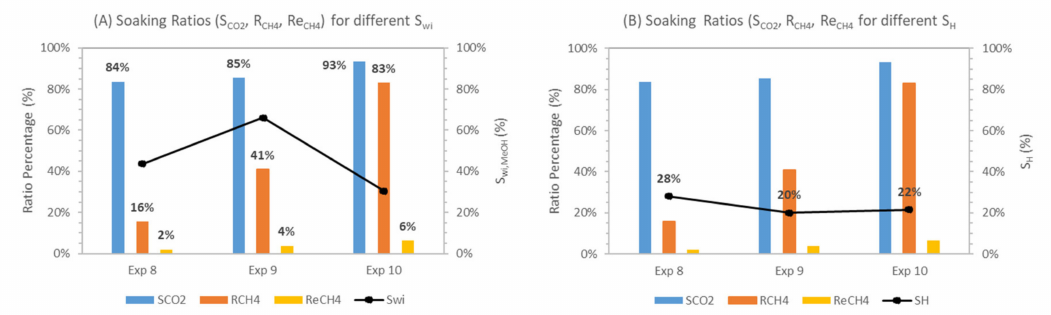
Figure 15. CH 4 -CO 2 exchange key recovery ratios for di ff erent initial water saturations and corresponding hydrate saturations. ( A ) Soaking ratios for di ff erent initial water saturation (S wi ) during experiments 8–10; ( B ) Soaking ratios for di ff erent hydrate saturation (S H ) during experiments